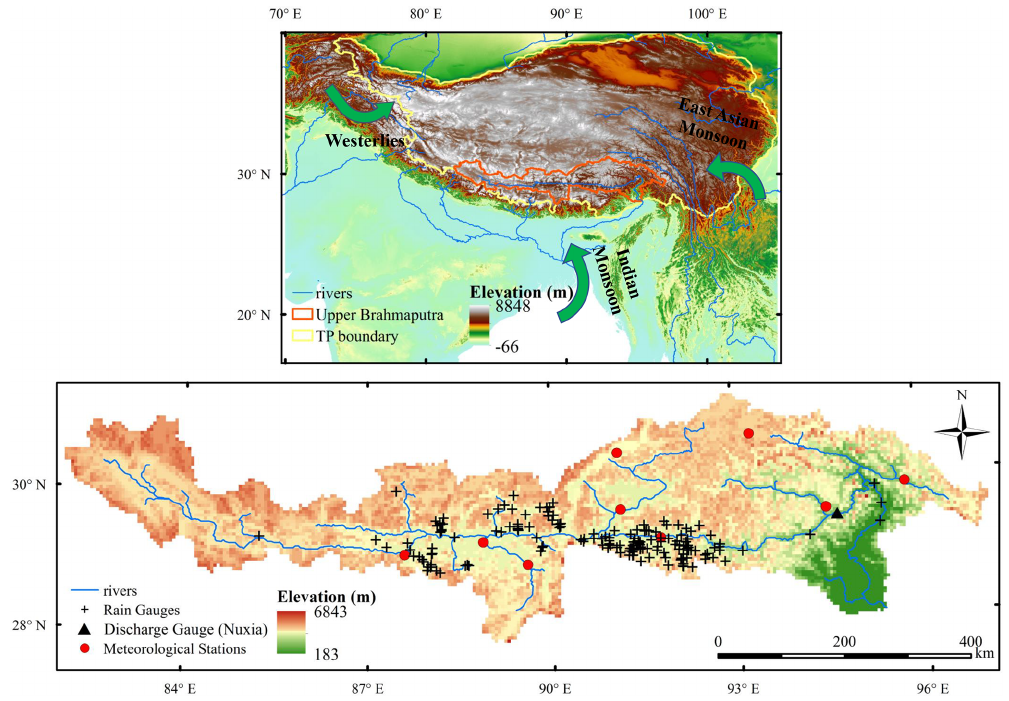
Figure 1. The upper Brahmaputra River basin originates from the Tibetan Plateau (TP) with the spatial distribution of nine meteorological stations from the China Meteorological Administration (CMA) and 166 rain gauges from the Ministry of Water Resources (MWR), China. The green arrow indicates the direction of the westerlies, the Indian monsoon, and the East Asian monsoon. The elevation data were obtained from the SRTM DEM datasets (https://earthexplorer.usgs.gov, last access: 30 January